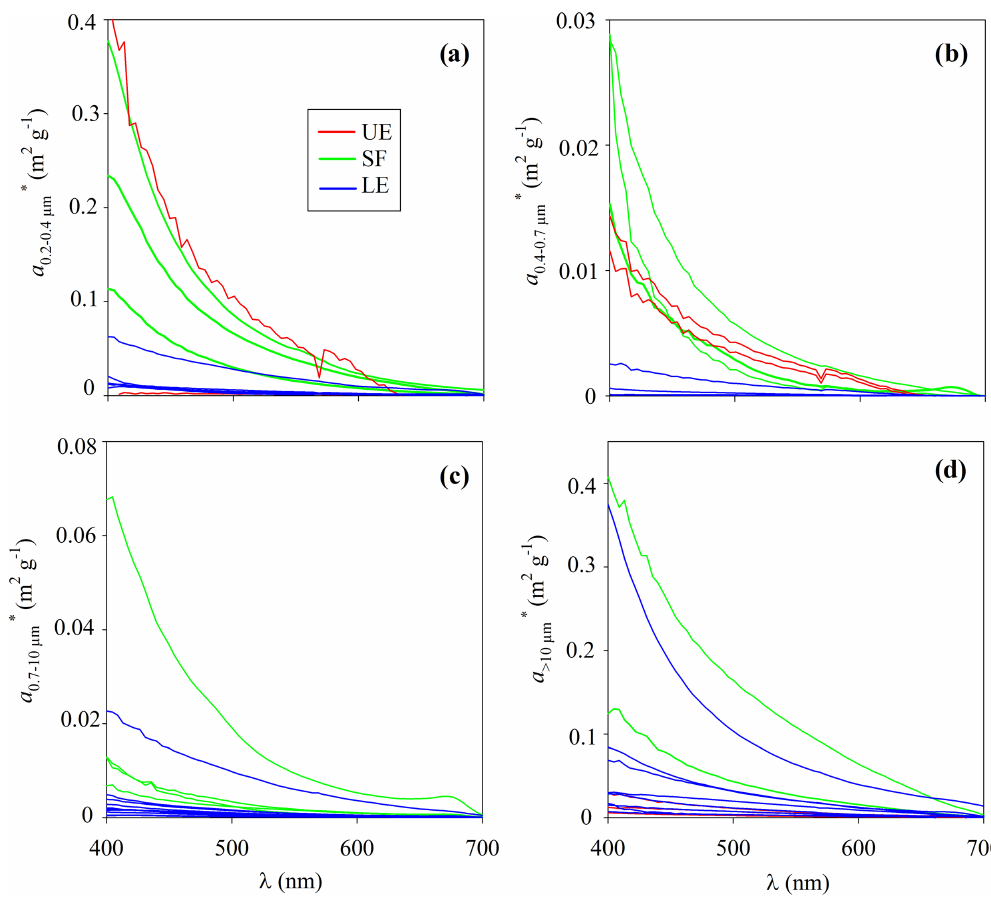
Figure 3. Spectral variation of mass-specific absorption coefficients for different size classes of suspended particulates: (a) 0.2–0.4µm, (b) 0.4–0.7µm, (c) 0.7–10µm and (d) >10µm. The color coding of symbols is similar to the one used in Fig. 2. Curves presenting negative values at some wavelengths are not depicted.